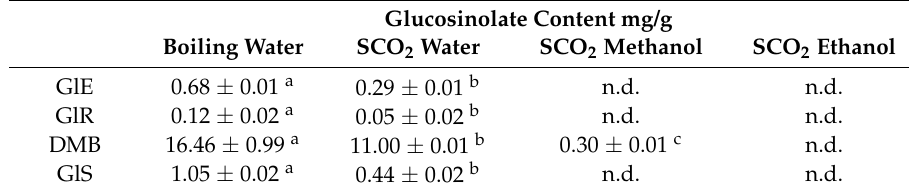
Table 3. Glucosinolates composition (mg/g) of Eruca sativa extract obtained by SCO 2 with different co-solvents.